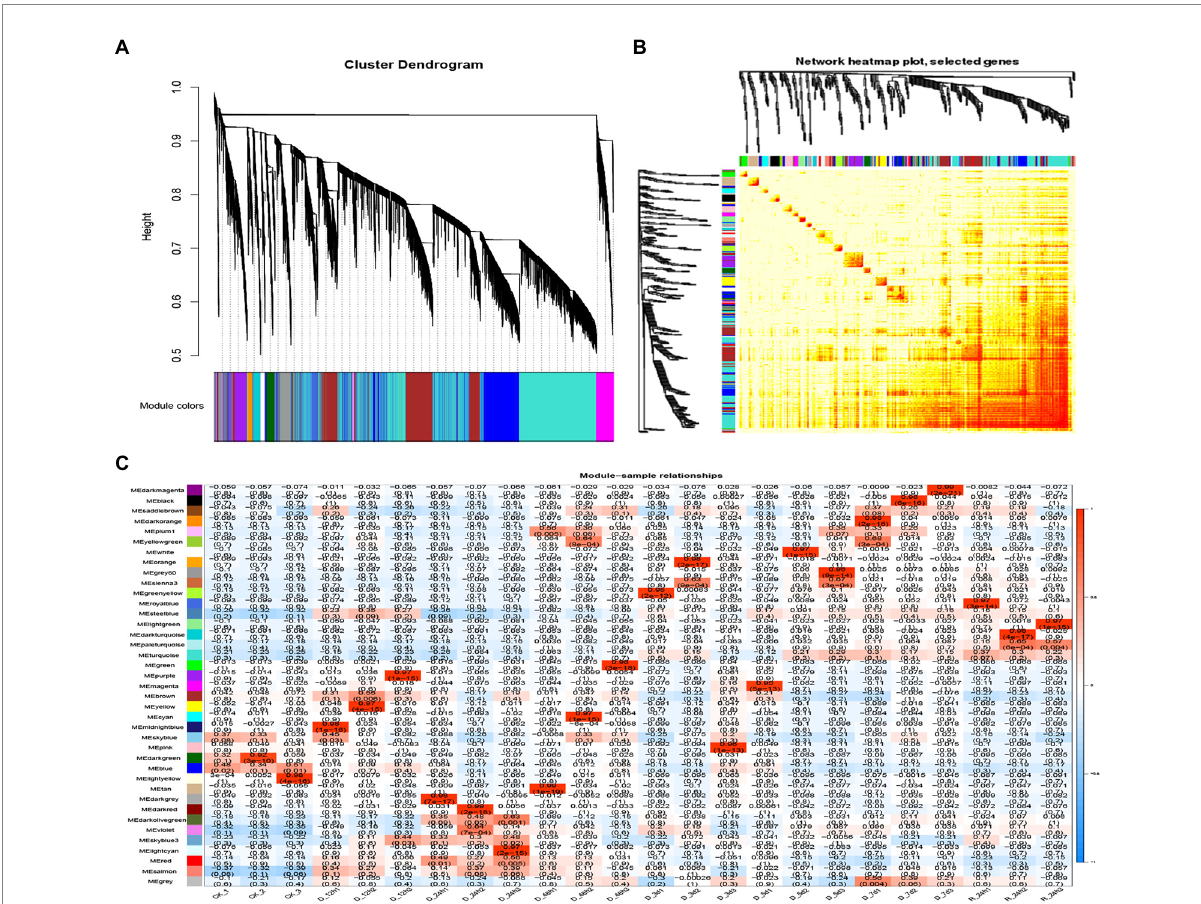
FIGURE 5 Correlation between sample clustering of the modules and genes. (A) Clustering dendrograms of the genes. Based on the dynamic hybrid branch cutting method, color strips were used for simple visualization of the module assignment (branch cutting). (B) 41,793 gene and module correlation clustering diagrams. (C) Heat map of the correlations between the modules and genes of different samples. The colors that range from blue through white to red indicate low through intermediate to high correlations,